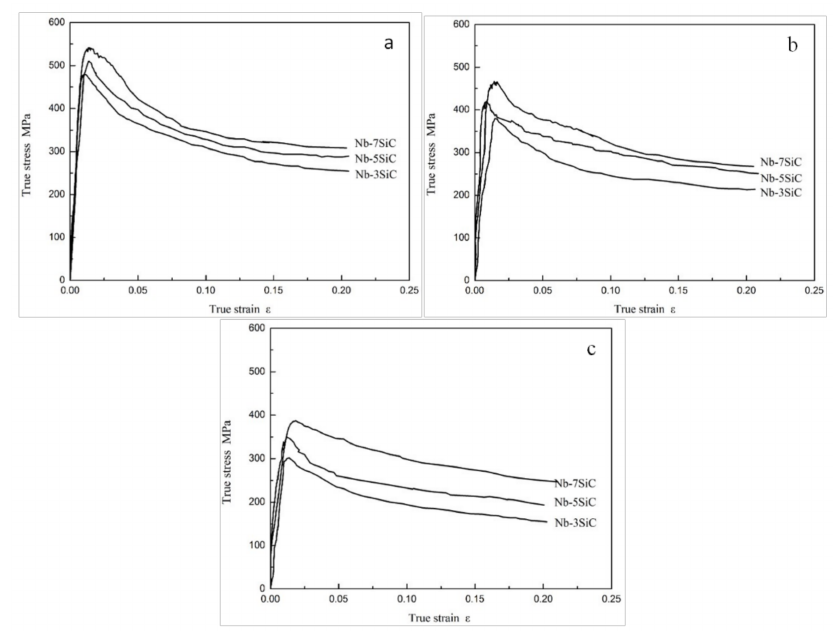
Figure 9. True stress-strain curves of the three materials at different temperatures: ( a ) 1050 ◦ C; ( b ) 1100 ◦ C; ( c ) 1150 ◦ C.